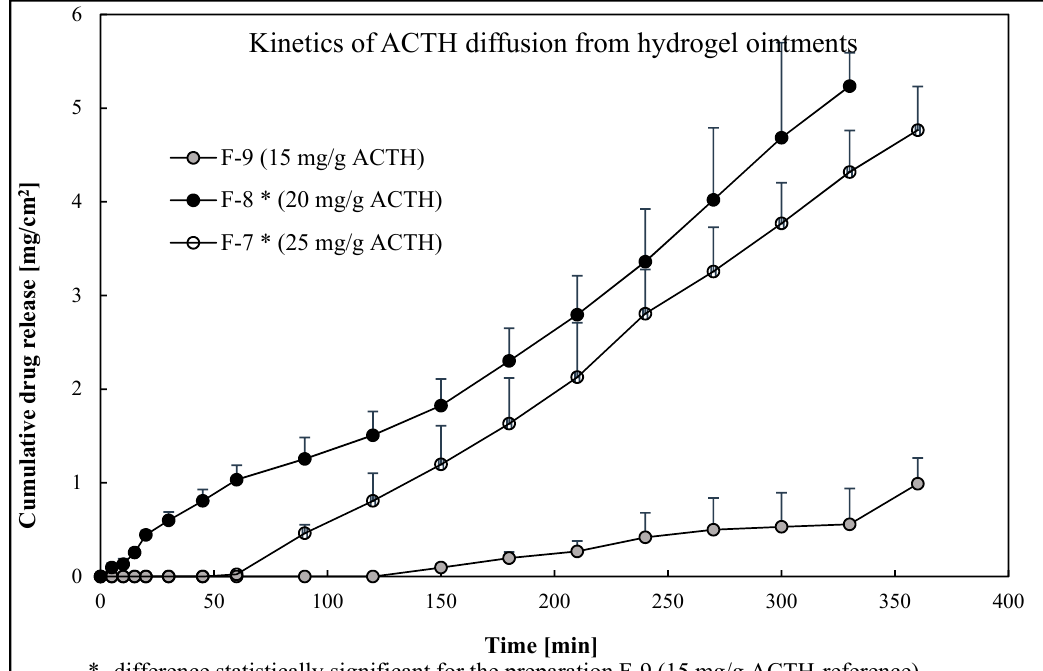
◦ C-cumulative drug